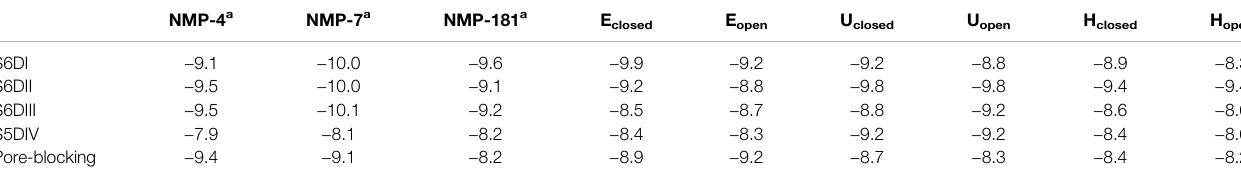
TABLE 4 | Interaction energies Δ G (kcal mol − 1 ) of the conformers of anandamide with the channel Ca v 3.2. NMP-4